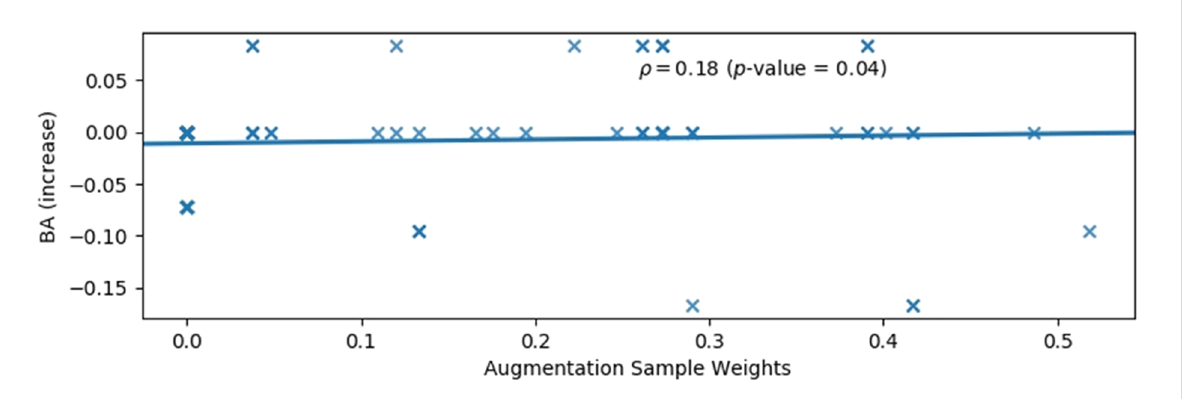
Figure 9: The change in cross-validated balanced accuracy (BA), with results shown for individual folds, obtained with Random Forest models for the 120 hpf excess lethality endpoint when the cross-validation training sets were supplemented with alternative samples, derived via replacing the training set sample endpoint values with the endpoint values for sub-lethal endpoints measured for the same materials, plotted against the weight given to these alternative samples. Here, the weight assigned was either the MCC correlation measure, if this was positive, or zero. The Spearman rank correlation coefficient is shown, along with the corresponding one-tail p -value for the null hypothesis that this is zero, that is, that there is no correlation between the change in performance and the relationship between the modelled and sub-lethal endpoint data used for data